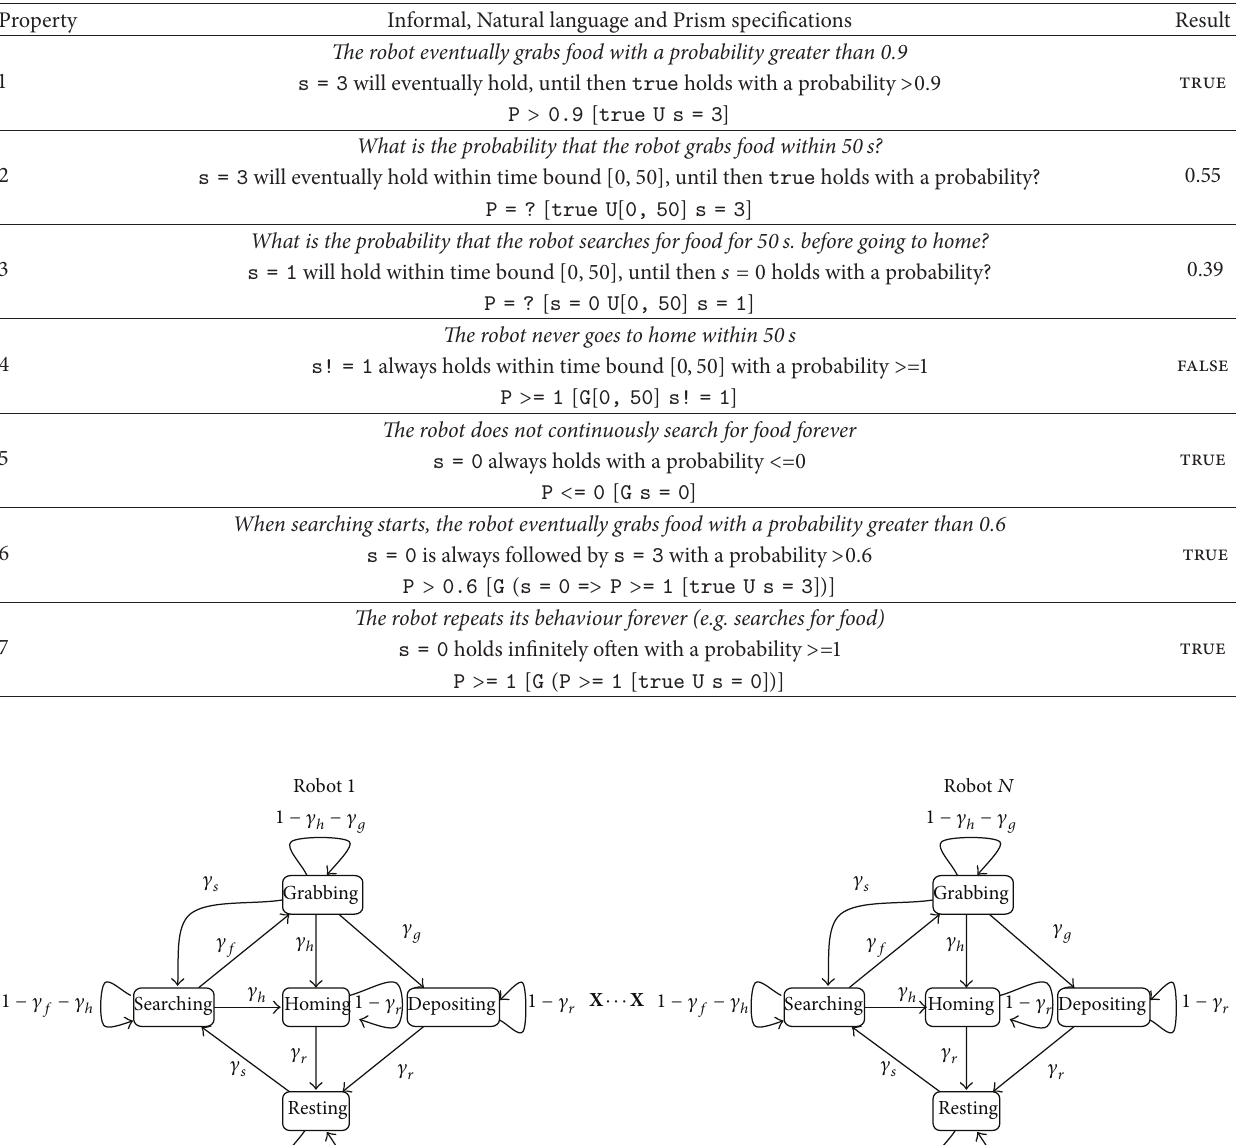
Table 2: Sample properties for a single robot.